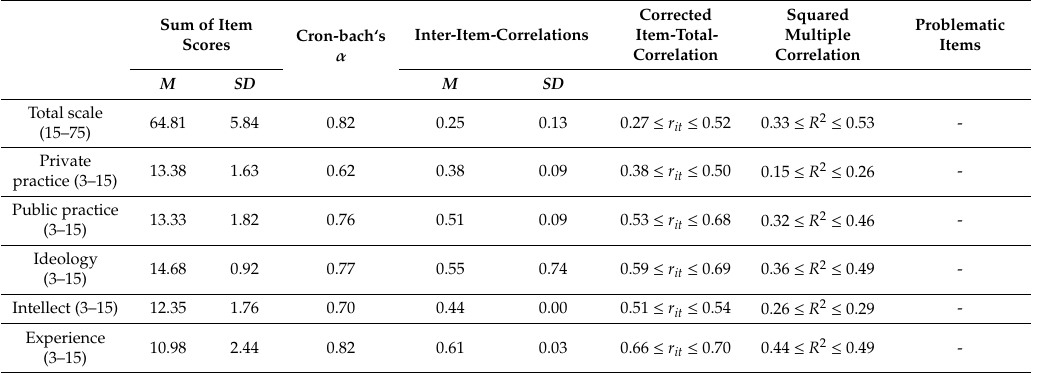
Table 2. Study 2: Summary of the results of the reliability analysis of the revised CRS and its subscales. Sum of Item Scores Cron-bach‘s α Inter-Item-Correlations